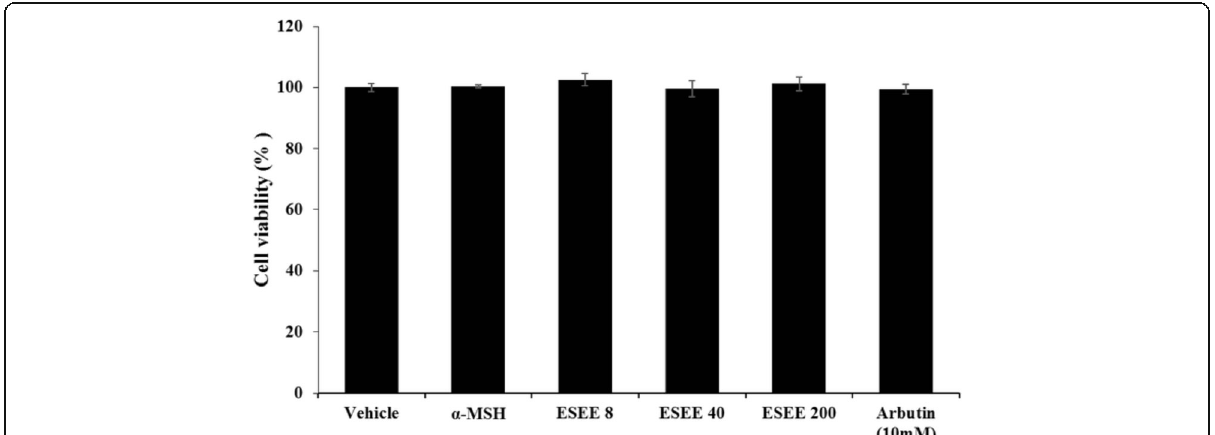
Fig. 1 Cell viability of the ES extract on the B16F10 cells. B16F10 cells were treated with various concentration of ES extract (8, 40, 200 μ g/ml) for